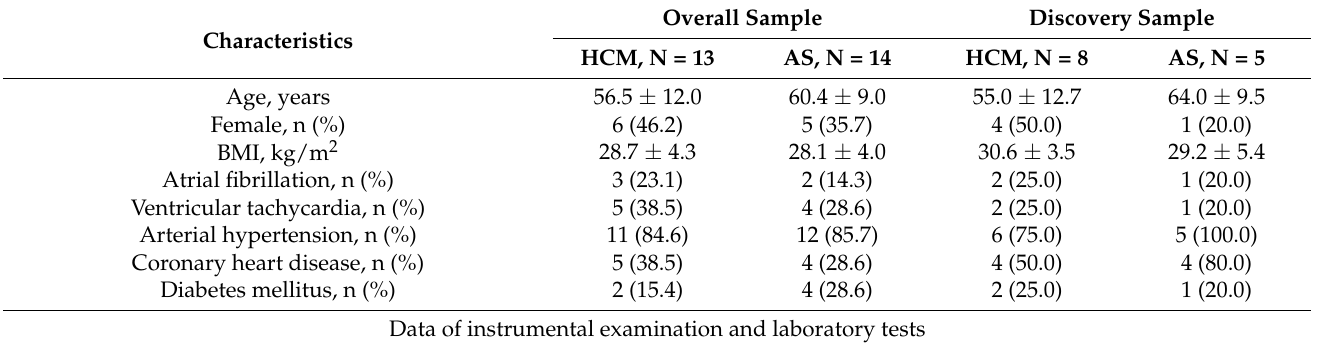
Table 1. Characteristics of HCM and AS patients involved in the